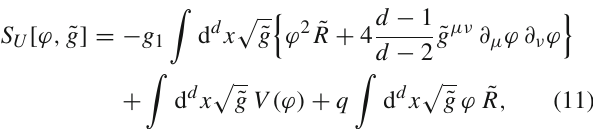
Fig. 1 Summaryofthetheoriesandthebreakingpatternsrelatingthem